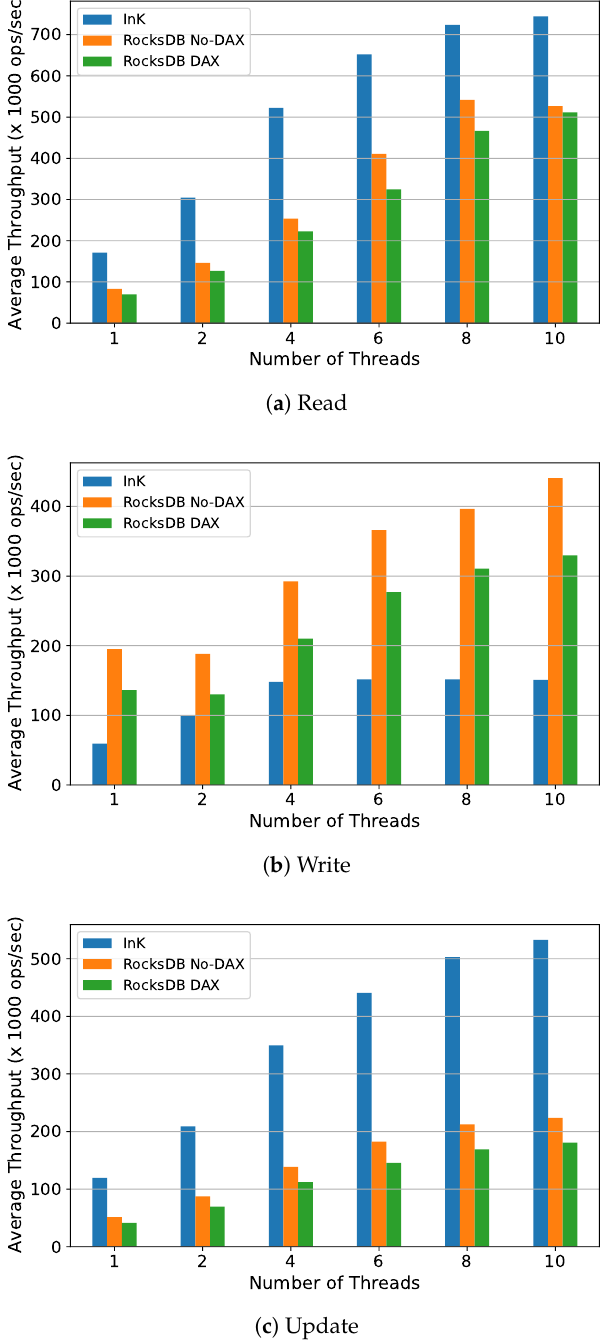
Figure 8. Aggregated throughput on multithreaded